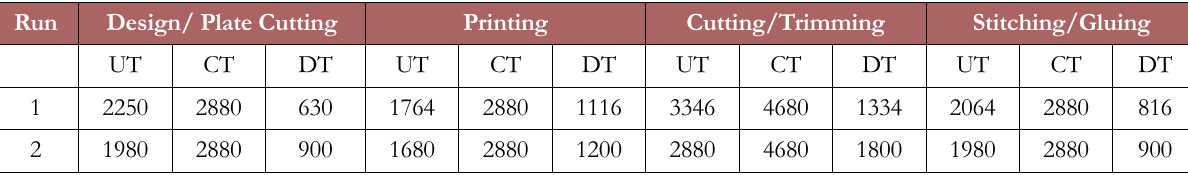
Table 1. Existing Down Time, Cycle Time, and Up Time (All time in